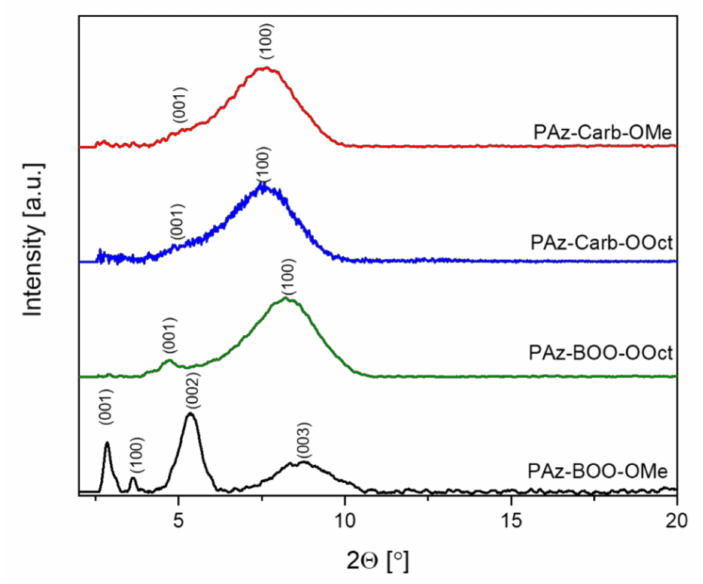
Figure 7. XRD patterns of imine thin films with possible assignment of Miller